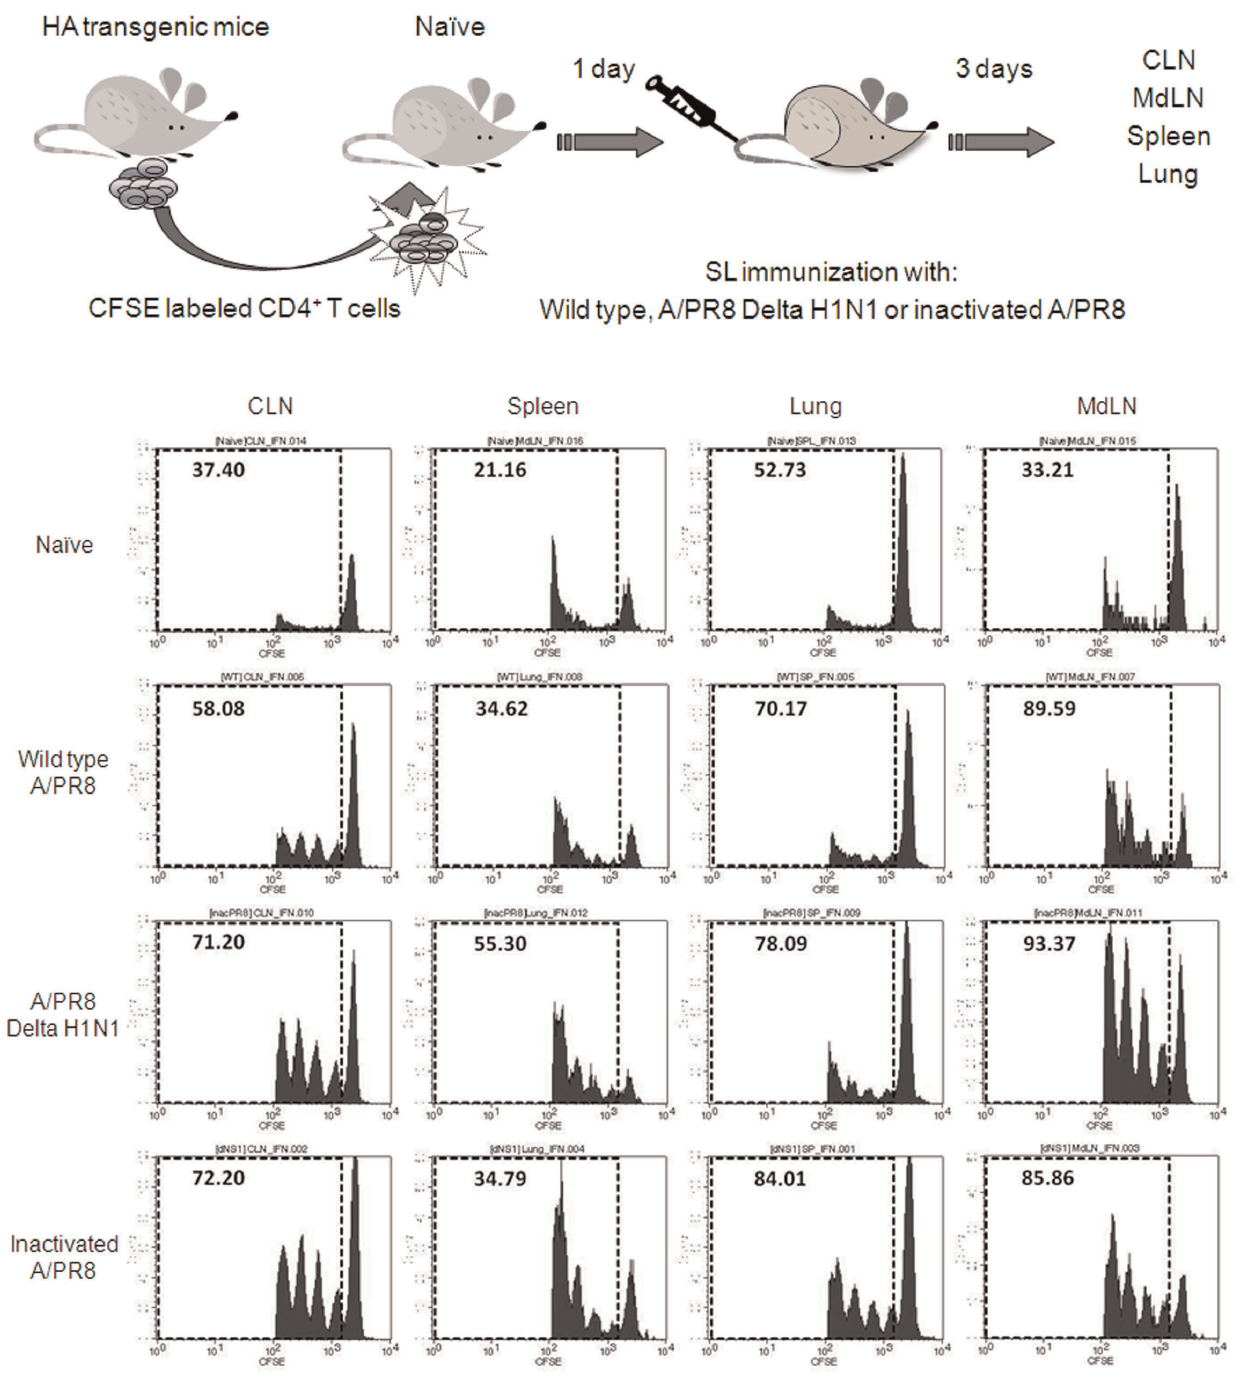
Figure 8. SL immunization with DelNS1 vaccine activates mucosal and extramucosal CD4 + T cells. CFSE-labeled CD4 + T cells from HA- TCR transgenic mice were adoptively transferred into naı¨ve mice. One day later, recipients were given SL 2 6 10 7 pfu of Delta H1N1, 2 6 10 5 pfu of mouse-adapted wt live or 40 m g of formalin-inactivated A/PR8. Three days after the immunization, proliferating (CFSE stained) HA-TCR CD4 + T cells were detected in cervical lymph nodes (CLN), lungs, mediastinal lymph nodes (MdLN) and spleens by FACS analysis. The data are representative of two experiments showing similar results. doi:10.1371/journal.pone.0039921.g008 Delta H1N1. Three days after the immunization, the proliferative observed in all lymph nodes analyzed, including MdLN. The activity of mononuclear cells from lungs, cervical lymph nodes proliferative activitiy of lymph node cells was comparable in SL (CLN), mediastinal (MdLN) and spleens was analyzed by flow immunized mice given either wt live virus or inactivated vaccine. cytometry. Proliferating HA-TCR transgenic CD4 + T cells were These results demonstrate that SL DeltaNS1 IAV efficiently